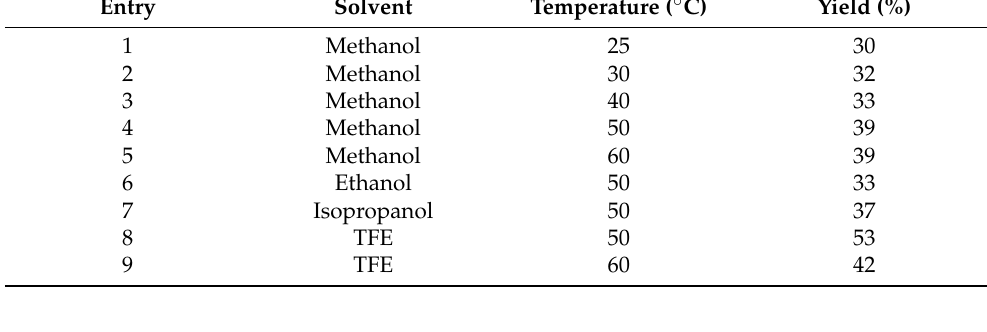
Table 1. Influence of solvent on model Ugi reaction.